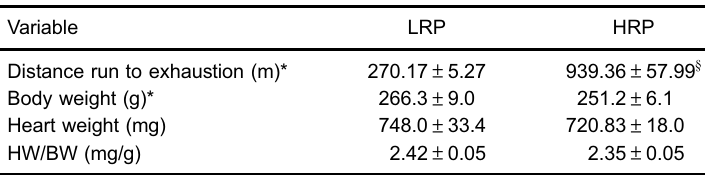
Table 1. Parameters of low running performance (LRP) and high running performance (HRP) groups.